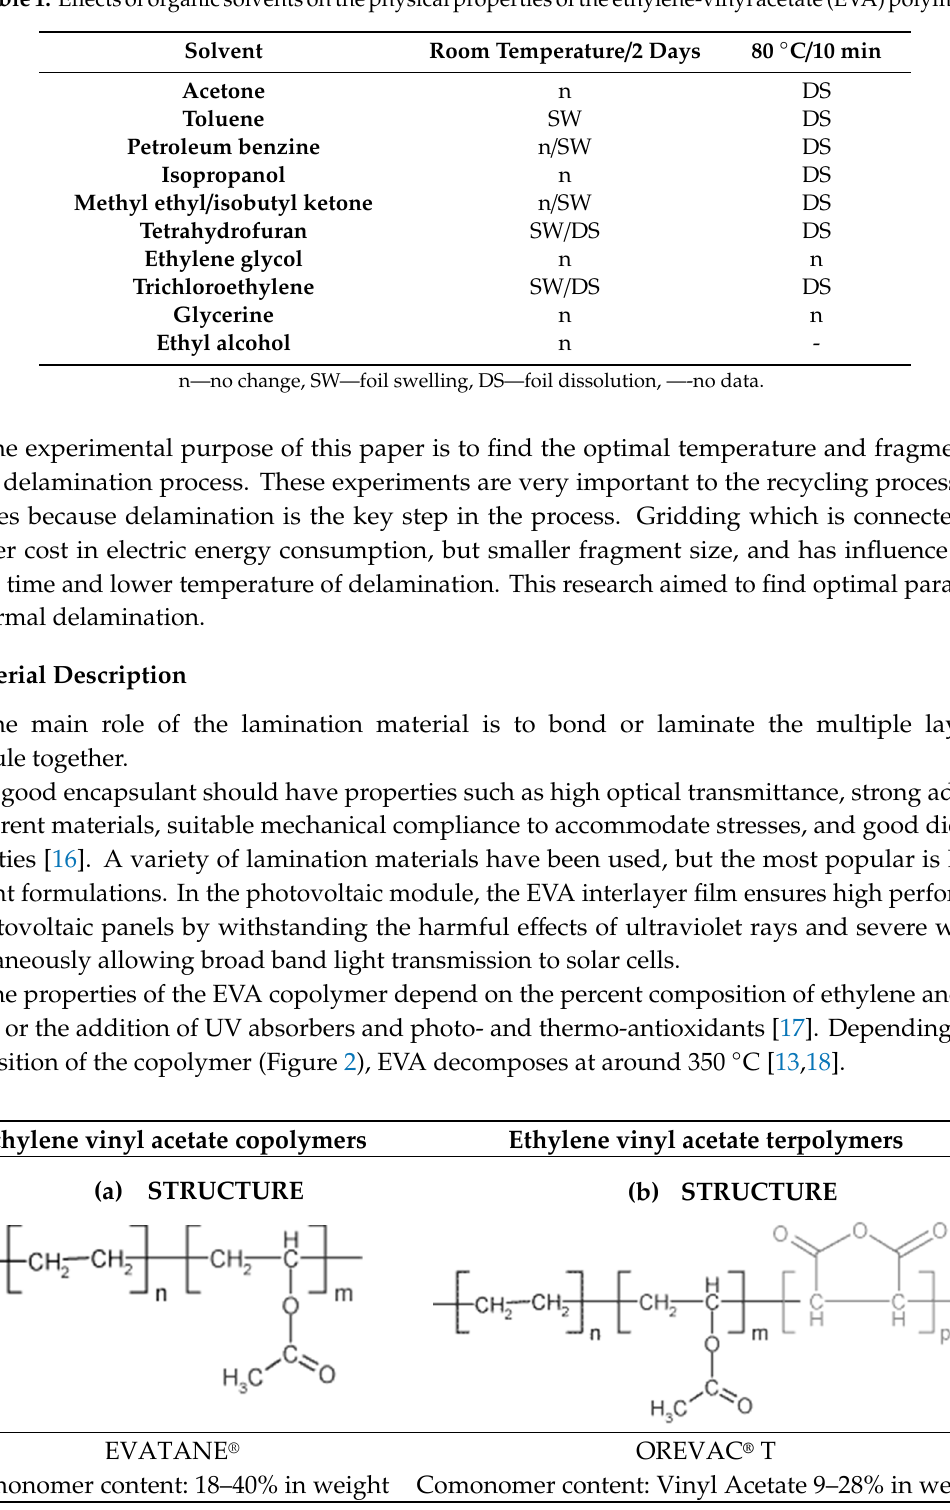
Figure 2. Structures of two kinds of EVA polymers ( a ) Ethylene vinyl acetate copolymers, ( b ) Ethylene vinyl acetate terpolymers.